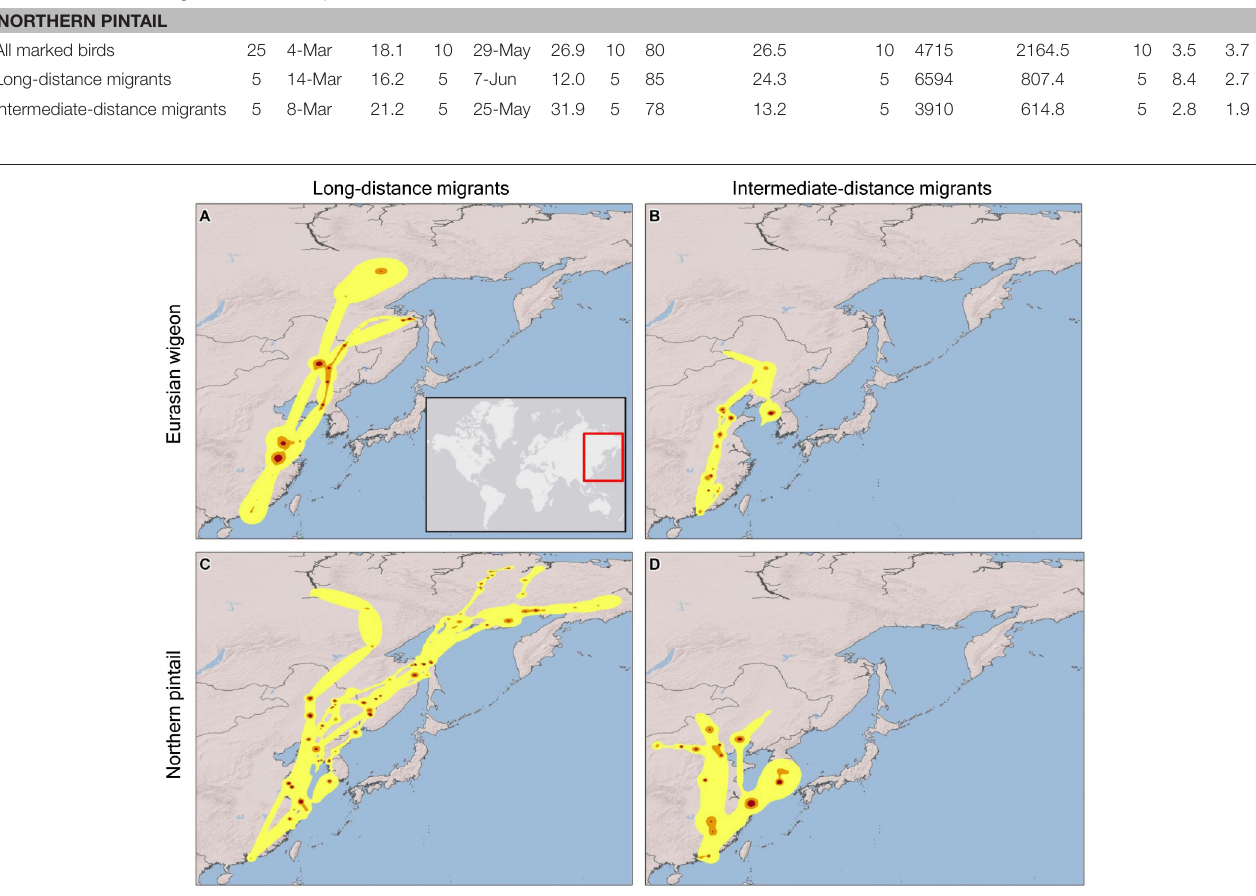
FIGURE 2 | Spring migration utilization distributions determined from dynamic Brownian Bridge Movement Models for Eurasian wigeon [long-distance migrants (A) , intermediate-distance migrants (B) ] and northern pintail [long-distance migrants (C) , intermediate-distance migrants (D) ] marked at Mai Po Nature Preserve in Hong Kong China from 2008 to 2009. Flight corridors (99%; yellow), core movement areas (75%; orange), and stopover locations (50%, red) are indicated.